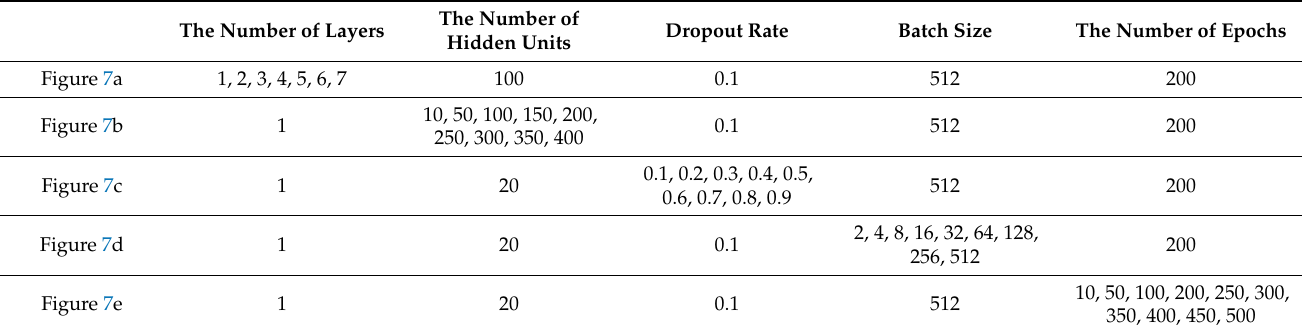
Table 5. The configurations of the hyper-parameters to investigate the effects of each hyper-parameter on the model performance in Figure 7. The controlled value for each hyper-parameter was borrowed from Kratzert, Klotz [37]. The Number of The Number of Layers Hidden